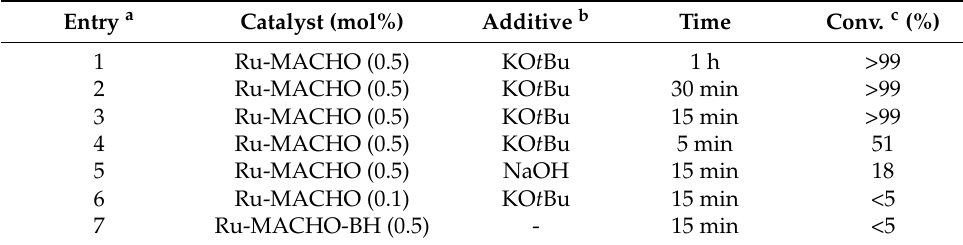
Table 1. Transfer hydrogenation of aldimines: Initial studies.